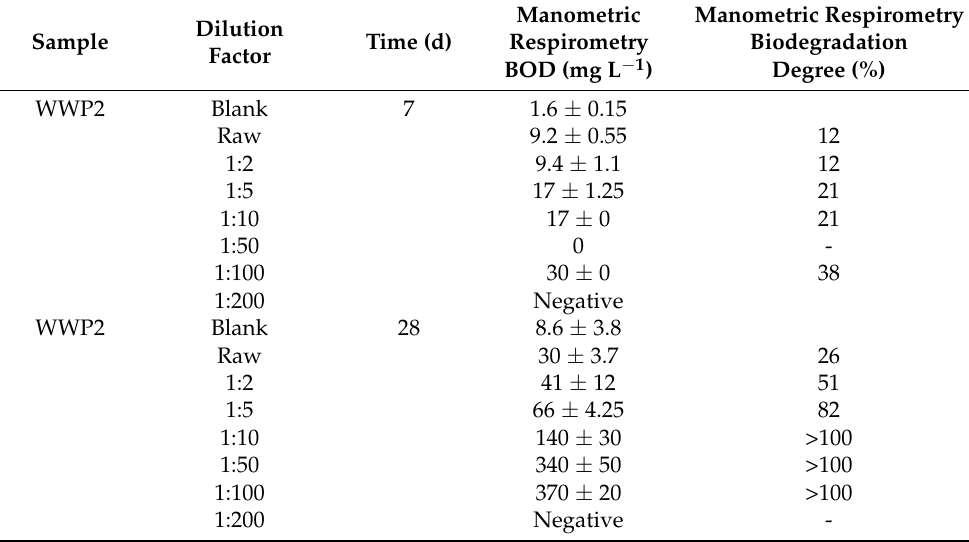
Table 5. The sample, dilution factor, and BOD values and the calculated biodegradation degrees of the WWP2 sample measured with the manometric respirometric